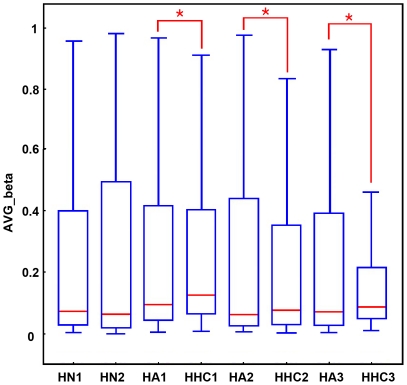
Average promoter methylation of single hepatocyte samples measured by BeadChip.Average promoter methylation of hepatocyte of normal liver (HN), adjacent liver (HA) and HCC (HHC) for all the 27,000 CpG loci. The illustrative box plots represent the mean, 25th percentile, 75th percentile and range of the data. Significant differences (P<0.05) between tumor and surrounding tissue are represented with an asterisk (*).